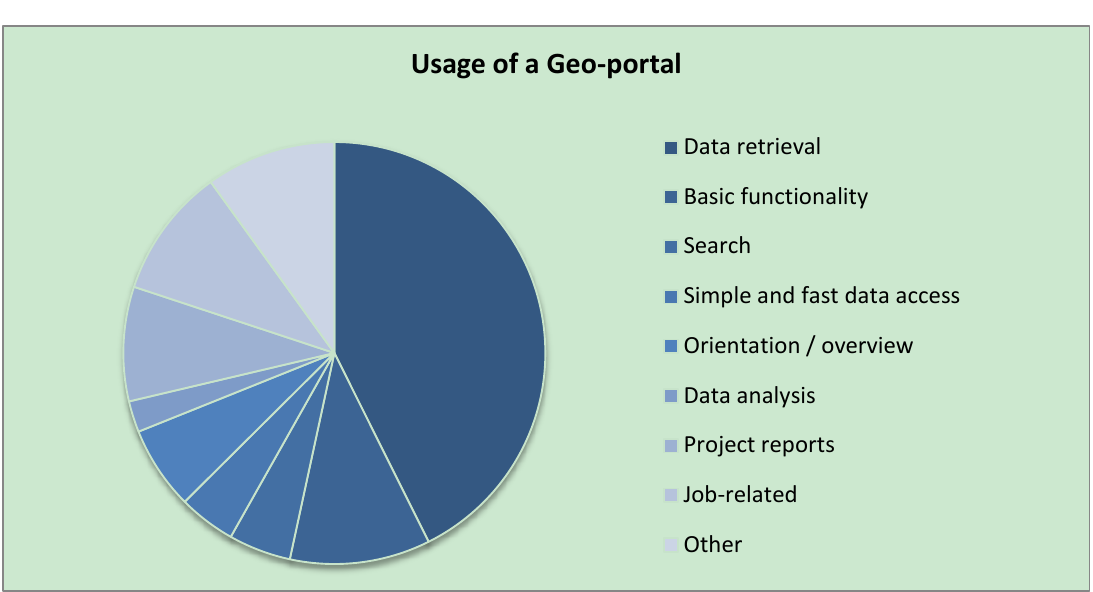
Figure 1. Usage of a Geo-portal.